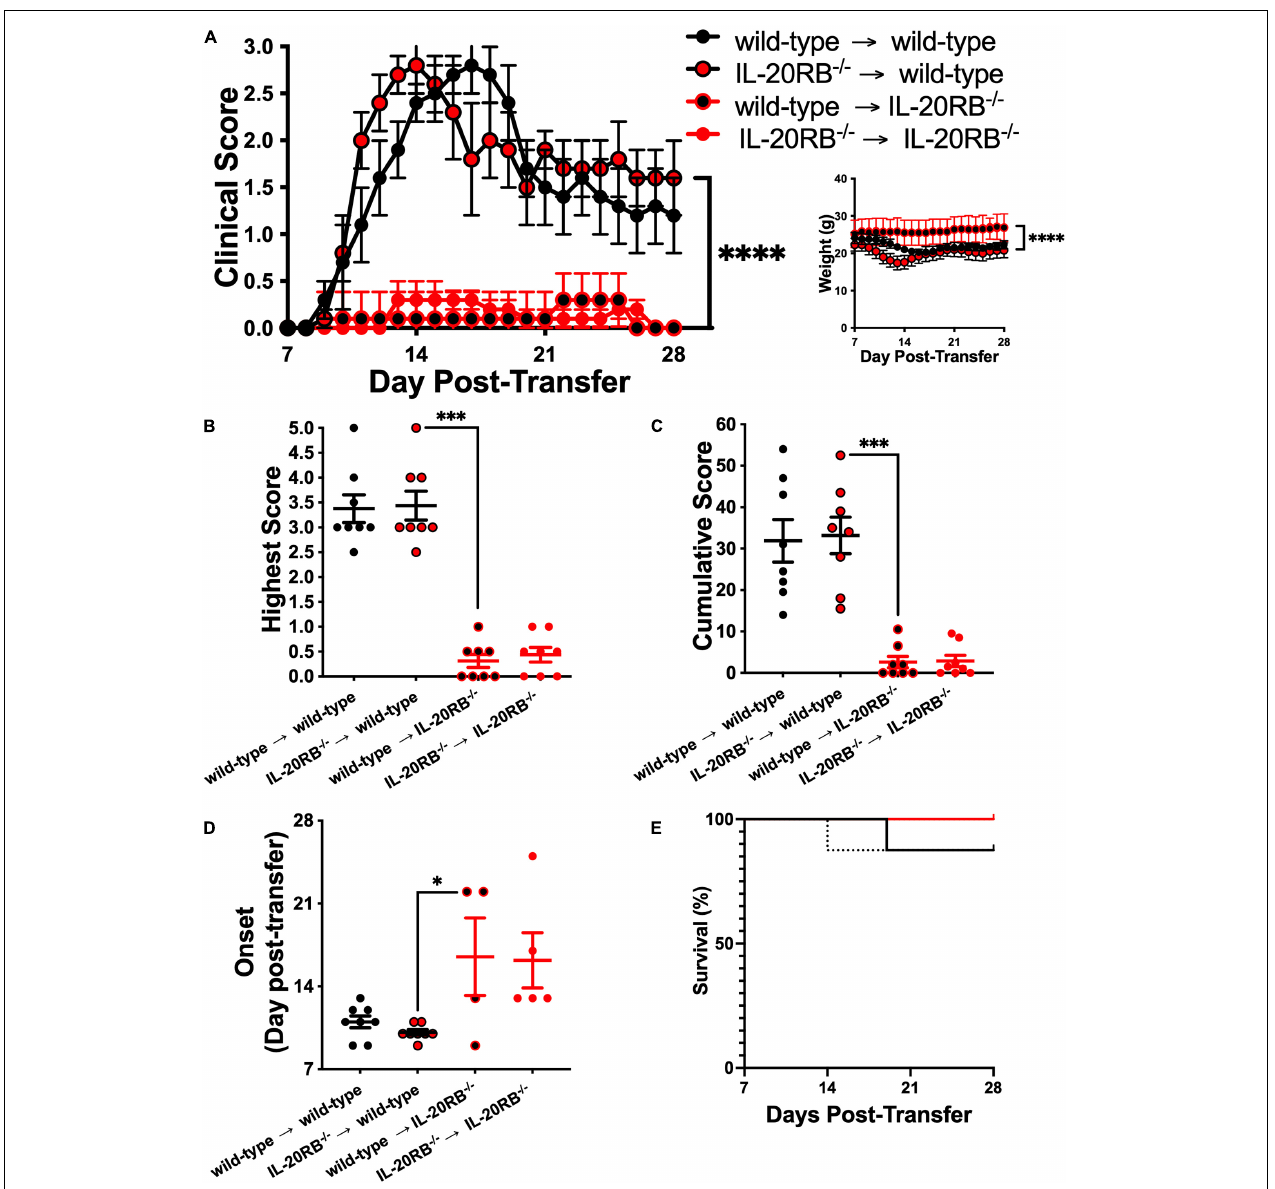
FIGURE 2 | Genotype of MOG-reactive Th1 cells does not contribute significantly to EAE while host genotype determines disease outcome. Ten week-old IL-20RB − / − mice and wild-type mice, male and female, were passively immunized for EAE with 10 6 cells of either IL-20RB − / − MOG-Th1 or wild-type MOG-Th1 cells ( n = 8). Donor to host mouse groups were the following: wild-type → wild-type mice (black circle), IL-20RB − / − → wild-type mice (red circle/black outline), wild-type → IL-20RB − / − mice (black circle/red outline), and IL-20RB − / − → IL-20RB − / − mice (red circle). Clinical score, body weight, highest and cumulative scores, and disease onset from 7 to 28 dpi were analyzed by non-parametric Kruskal–Wallis followed by Dunn’s post hoc test comparing primarily IL-20RB − / − → wild-type mice with wild-type → IL-20RB − / − mice (A–D) . Wild-type → wild-type mice (mean ± SEM clinical score: 1.53 ± 0.18, body weight: 21.93 ± 0.25), and IL-20RB − / − → IL-20RB − / − mice (mean ± SEM clinical score: 0.13 ± 0.03, body weight: 26.10 ± 0.28) showed outcomes comparable to wild-type mice and IL-20RB − / − mice with EAE ( Figure 1A ); but differences in clinical score and body weight between IL-20RB − / − → wild-type mice (mean ± SEM clinical score: 1.66 ± 0.17, body weight: 20.09 ± 0.28), and wild-type → IL-20RB − / − mice (mean ± SEM clinical score: 0.11 ± 0.02, body weight: 25.99 ± 0.11) showed extreme statistical significance, p < 0.0001 (A) . Highest (B) and cumulative scores (C) analysis showed high statistical significance between IL-20RB − / − → wild-type mice (mean ± SEM highest score: 3.44 ± 0.29, cumulative score: 33.19 ± 4.41), and wild-type → IL-20RB − / − mice (mean ± SEM highest score: 0.31 ± 0.13, cumulative score: 2.62 ± 1.37), p < 0.001. Analysis of EAE disease onset for mice with neurologic symptoms (wild-type → wild-type mice and IL-20RB − / − → wild-type mice, 8/8; wild-type → IL-20RB − / − mice, 4/8, and IL-20RB − / − → IL-20RB − / − mice, 5/8) showed statistical significance between IL-20RB − / − → wild-type mice (mean ± SEM: 10.13 ± 0.23) and wild-type → IL-20RB − / − mice (mean ± SEM: 16.50 ± 6.07), p < 0.05 (D) . Again, highest and cumulative scores, and disease onset (B–D) of wild-type → wild-type mice (mean ± SEM highest score: 3.38 ± 0.28, cumulative score: 31.88 ± 5.12, disease onset: 11.00 ± 0.50) and IL-20RB − / − → IL-20RB − / − mice (mean ± SEM highest score: 0.44 ± 0.15, cumulative score: 2.88 ± 1.38, disease onset: 16.2 ± 2.33) were similar as the ones observed for wild-type mice and IL-20RB − / − mice with EAE ( Figures 1B–D ). Analysis of percentage of survival was not deemed significant (E) . Results are shown as mean ± SEM, ∗ p < 0.05, ∗∗∗ p < 0.001, and ∗∗∗∗ p <